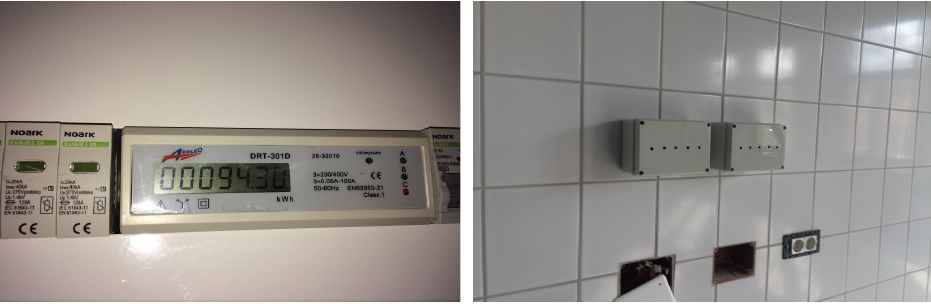
Fig. 17. Electric consumption meters Fig. 18. Interior comfort